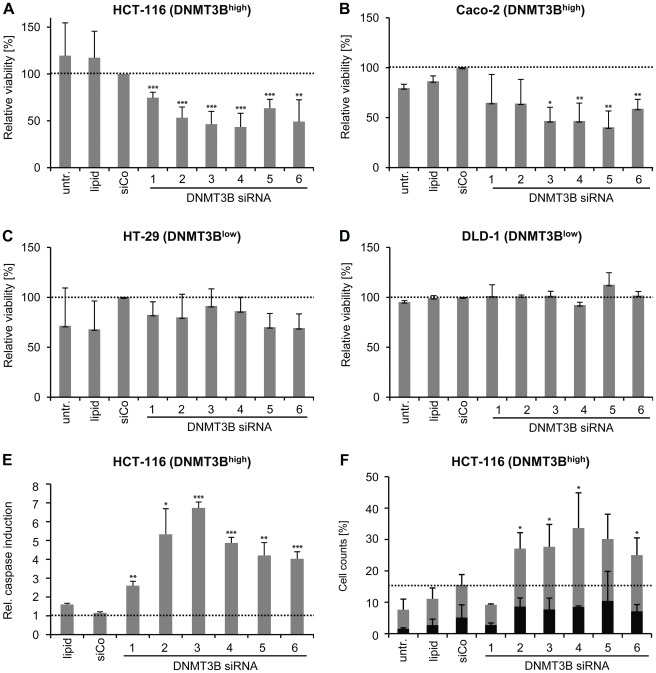
DNMT3B is required for survival of DNMT3B-overexpressing colon cancer cells.(A–D) Proliferation assays of colon cancer cells expressing high (A: HCT-116, B: Caco-2) or low (C: HT-29, D: DLD-1) levels of DNMT3B. Cell viability was measured 72 h after the first transfection (see Material and Methods) and normalized to cells transfected with non-targeting control siRNA (siCo); untr., untreated cells; lipid, transfection reagent control. Each sample was analyzed in quadruplicates; data are shown as mean ± SD, relative viability was used for normalization and set to 100% for siCo treated cells. (E) Caspase 3/7 activation assay of HCT-116 cells after siRNA knockdown of DNMT3B. Each sample was analyzed in quadruplicates; data are shown as mean±SD, relative viability was used for normalization and set to 100% for siCo treated cells. (F) FACS analysis of Annexin V-FITC and propidium iodide (PI) staining on HCT-116 cells after siRNA knockdown of DNMT3B is shown. Annexin V positive cells and the sum of Annexin V-positve and PI-positive cells were quantified. Values indicate means of three independent experiments. Error bars represent standard deviations. *P<0.05 relative to control siRNA (siCo), **P<0.01 relative to control siRNA (siCo), ***P<0.001 relative to control siRNA (siCo), determined by student's t-test prior to normalization.